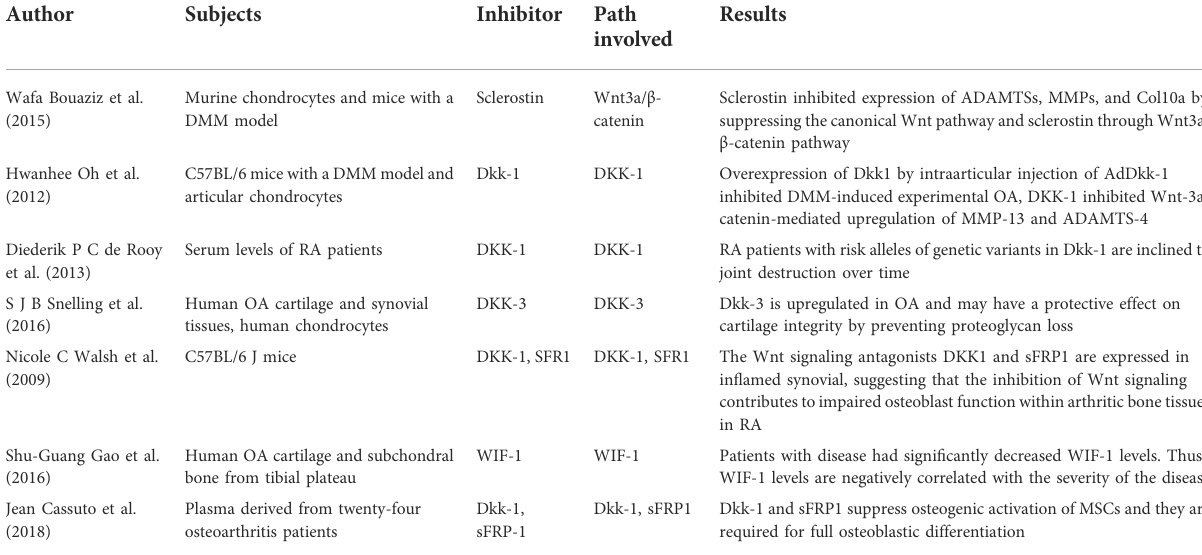
TABLE 4 Endogenous inhibitors of the Wnt/ β -catenin signaling